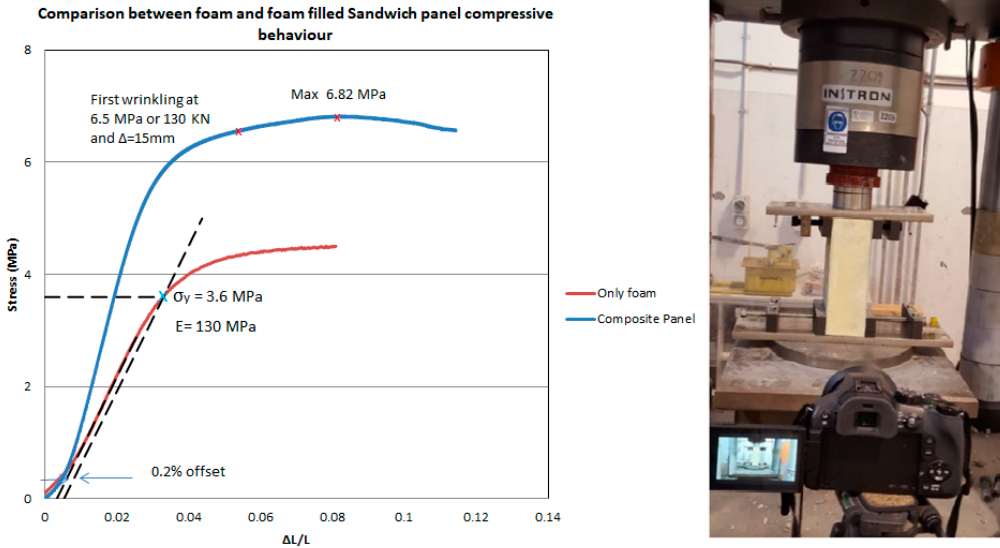
Figure 6. Test setup and design elastoplastic diagram of composite panel under edgewise compression, and the determination of module of elasticity